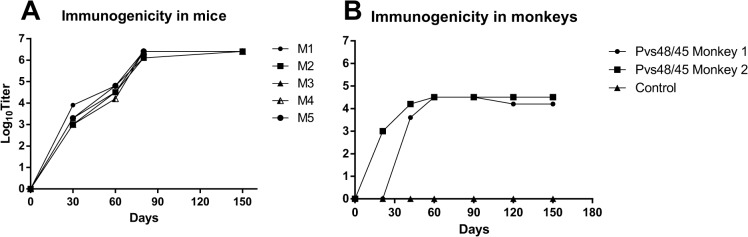
Immune responses to rPvs48/45.In A. BALB/c mice. Serum samples were collected pre-immunization on day 0 and post-immunization on days 30, 60, 90 and 150 and B. Aotus lemurinus griseimembra. Kinetics of antibody titers in Aotus during immunization and follow-up period. Experimental monkeys immunized with 50 μg rPvs48/45 formulated in Montanide ISA-51; Control monkey immunized with a mixture of Montanide ISA-51 and PBS 1X. Titers correspond to the last dilution of the test sera in which OD405 values were above that of the cut-off. Cut-off value were defined as pooled naïve mouse or monkey sera, OD405 plus 3SD. Serum samples were tested at two-fold serial dilutions (1x102–2x105); a pool serum from naïve mice was used as negative control.